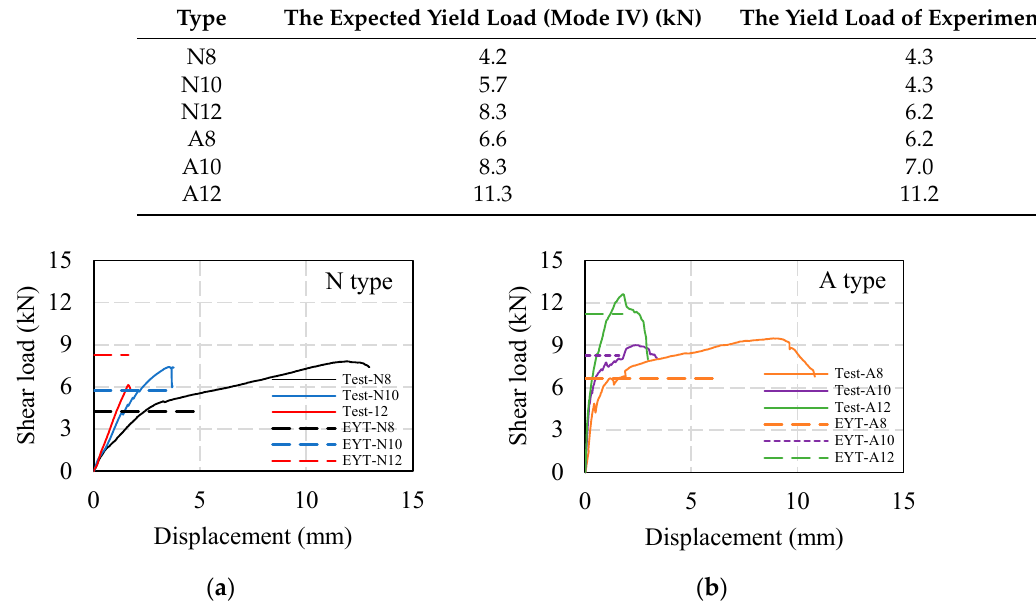
Table 10. Comparison of the experimental and theoretical results of a shear specimen. Type The Expected Yield Load (Mode IV) (kN)